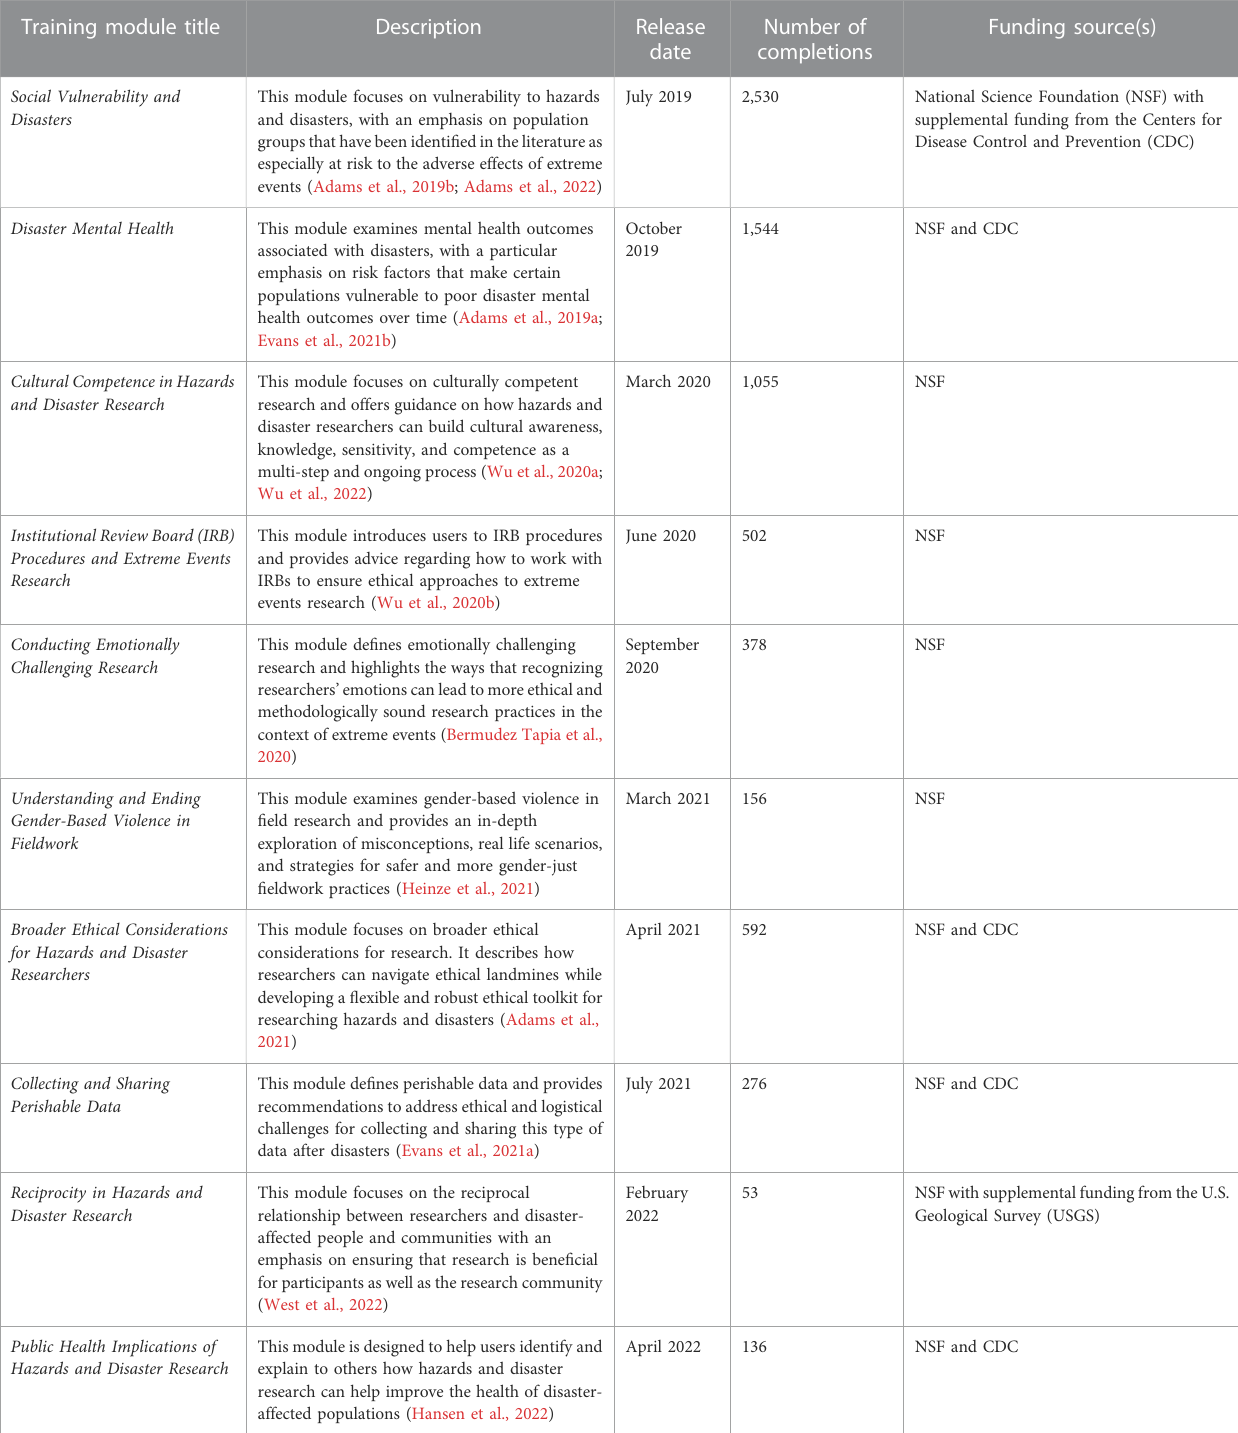
TABLE 1 Summary of CONVERGE Training Modules released between July 2019 and November